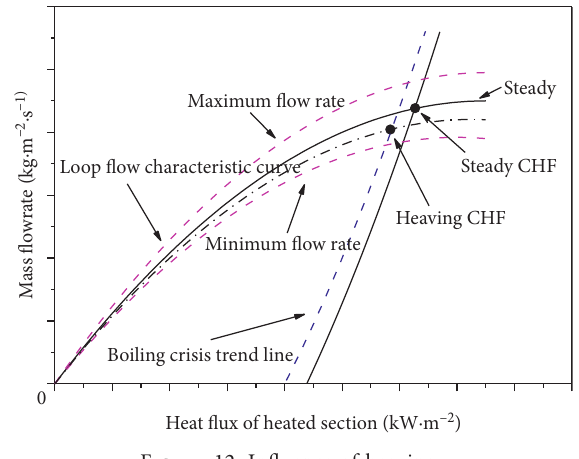
Figure 12: Influence of